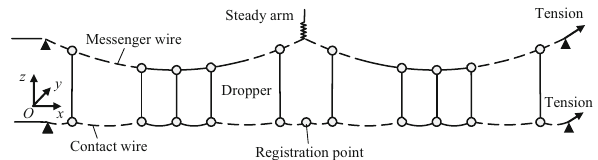
Fig. 1 Sketch of